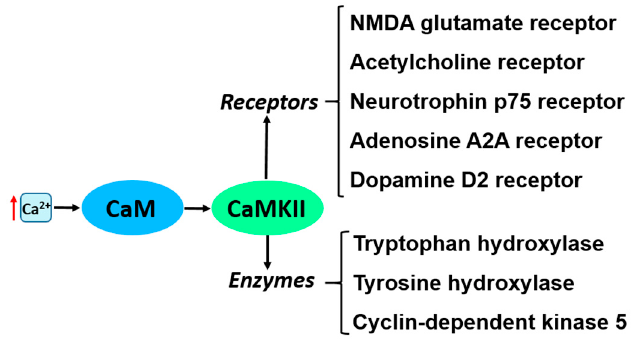
Figure 2. List of receptors and enzymes activated by Ca 2+ - CaM-CaMKII and potentially involved in PD. Red arrow indicates increase in intracellular Ca 2+ concentration.